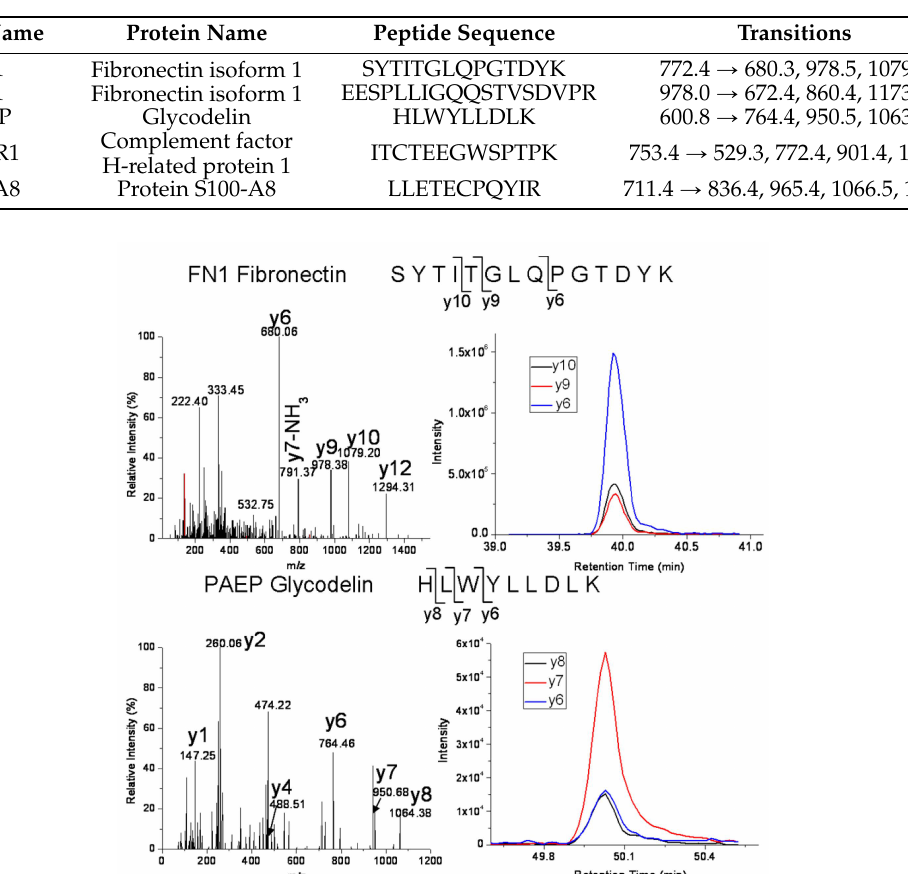
Table 3. List of targeted proteins and corresponding peptides and transitions for the developed MRM assays.